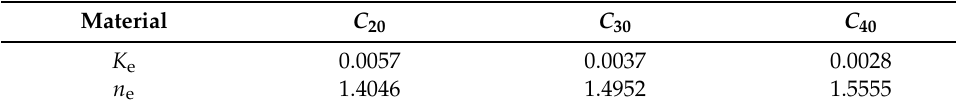
Figure 2. Impact erosion process of saltation particles to the vertical wall in a sand drift. Table 2. Parameters of erosion